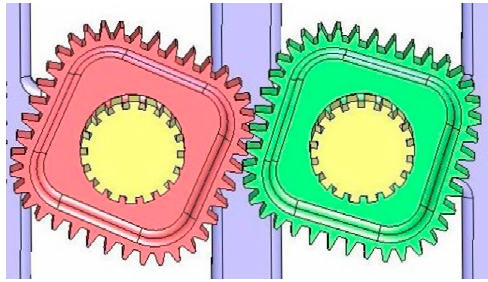
Figure 2. Historical model of non-circular gear [10].